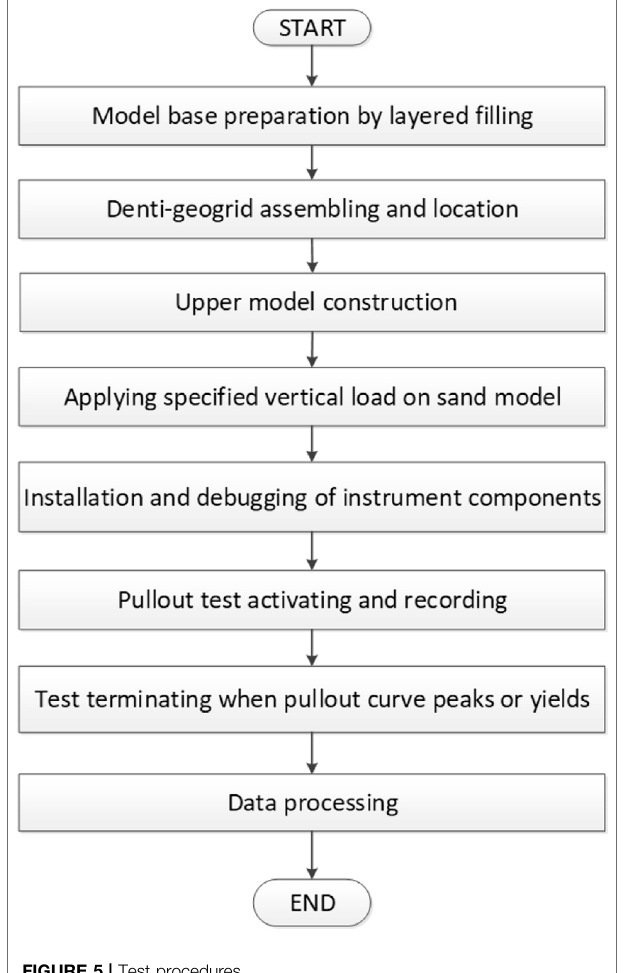
FIGURE 5 | Test procedures.